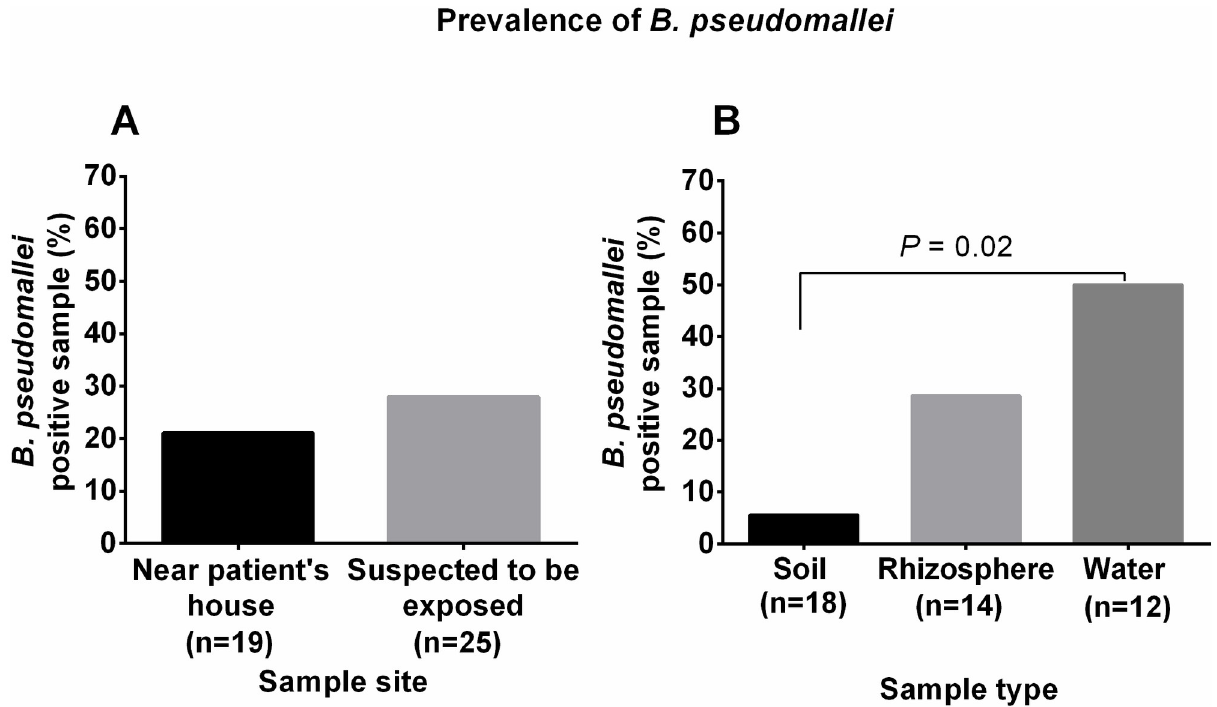
Fig 3. Prevalence of B . pseudomallei positive samples at two sampling sites among different sample types. (A) Prevalence of B . pseudomallei positive samples between two sampling sites. (B) Prevalence of B . pseudomallei positive samples in the soil, rice rhizosphere and water.